Question: Provide a publication-style caption for this figure.
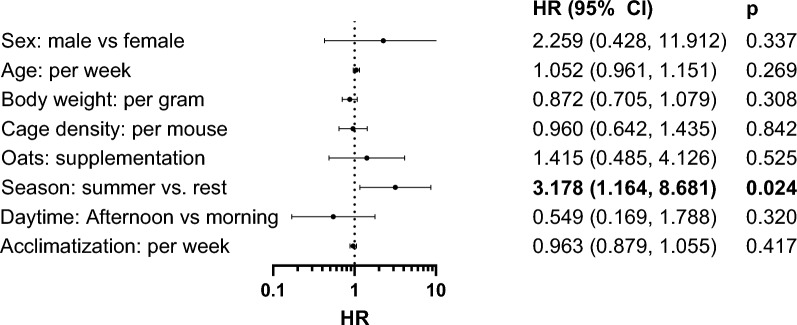
Answer: Forest plot of hazard ratios from multivariate Cox proportional hazards regression analysis. Hazard ratios with 95% confidence intervals for all variables included in the model are displayed. Significant hazard ratios and P —values are in bold letters